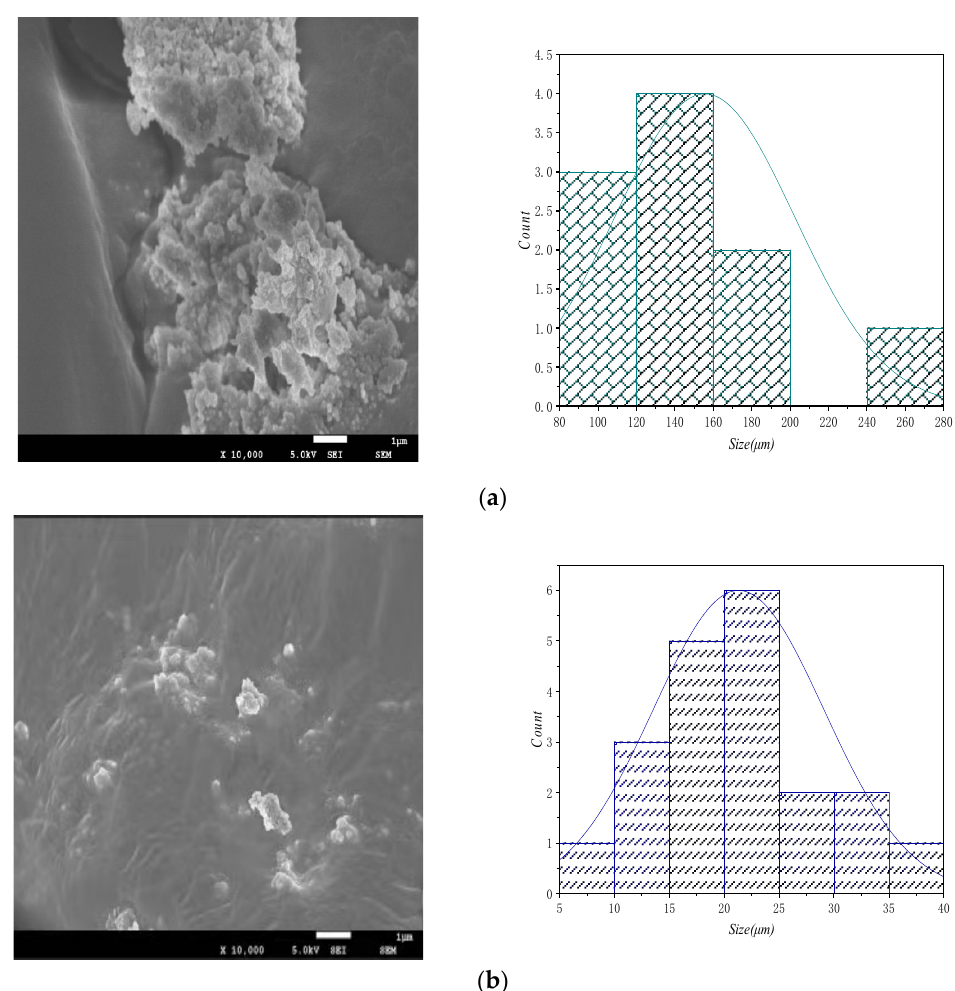
Figure 15. Scanning electron micrograph before and after ultrasonic disposal 10,000×. ( a ) Scanning electron micrograph (10,000×) and particle size distribution before ultrasonic treatment. ( b ) Scanning electron micrograph (10,000×) and particle size distribution after ultrasonic treatment.